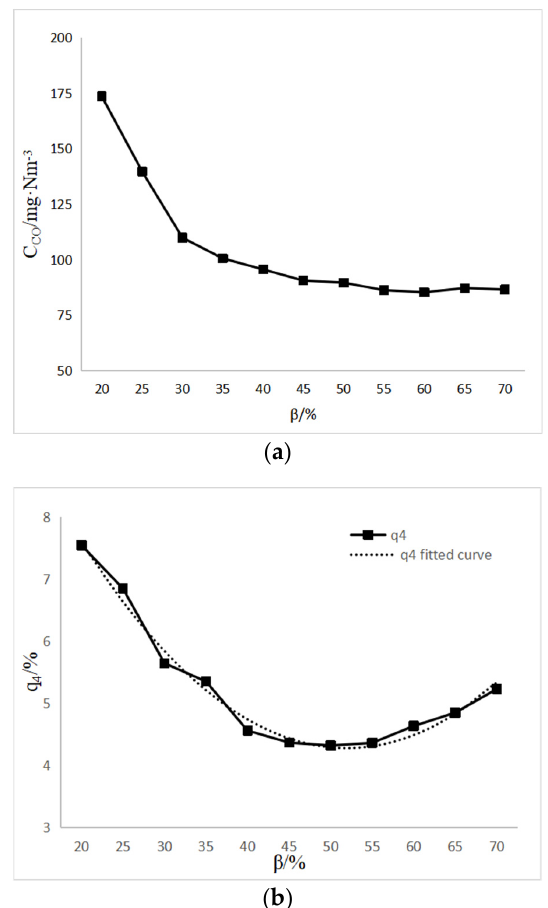
Figure 5. Influence of β on q 4 and CO emission concentration. ( a ) Influence of β on q 4 . ( b ) Influence of β on CO emission concentration.